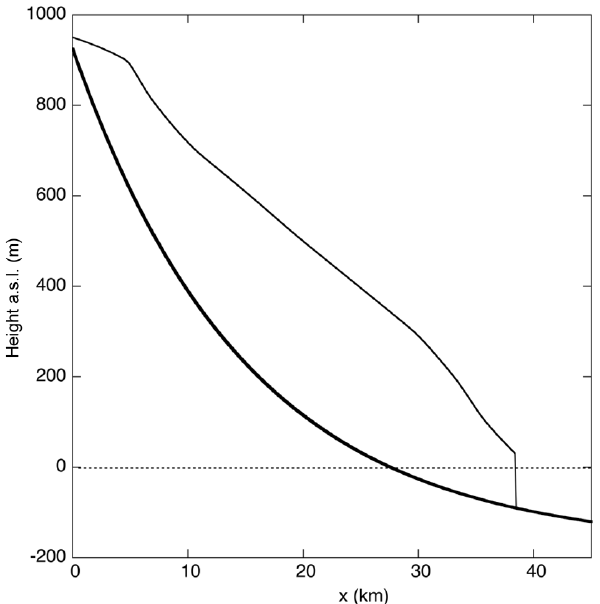
Figure 3. Upper curve: glacier surface elevation of Monaco- breen along the flowband according to the topographic map (http: //toposvalbard.npolar.no, last access: 14 September 2018). Lower curve: the bed profile as used in the